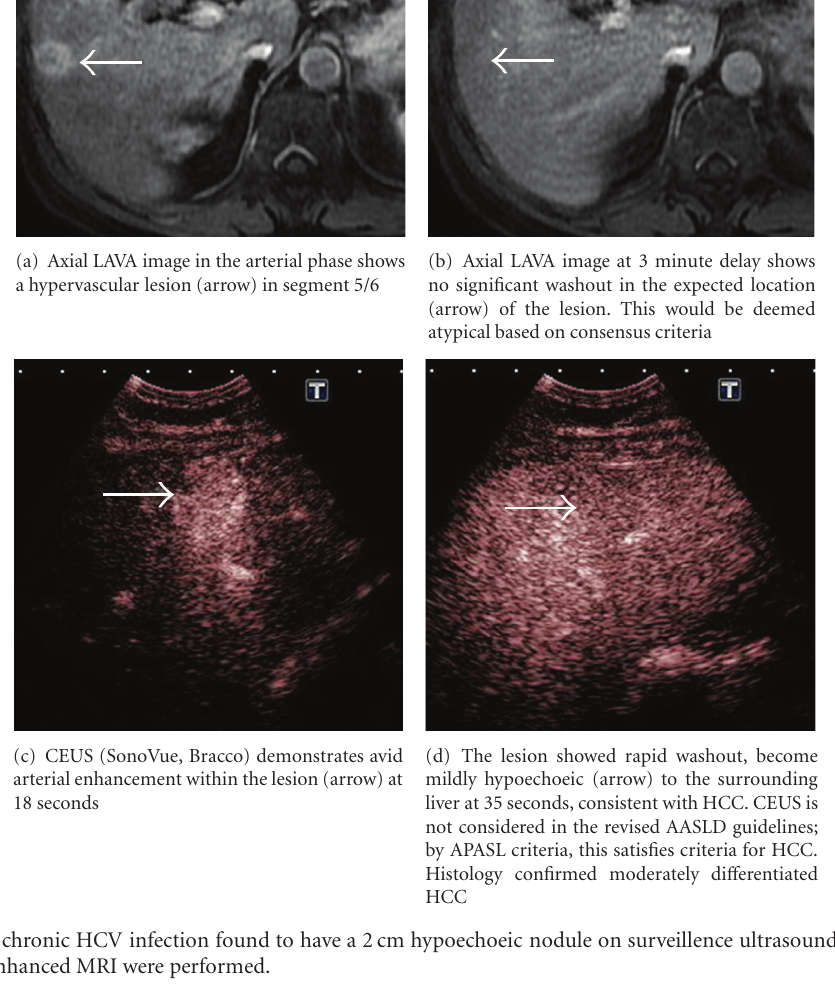
Figure 2: Patient with chronic HCV infection found to have a 2cm hypoechoeic nodule on surveillence ultrasound scan. Both CEUS and multiphasic contrast-enhanced MRI were